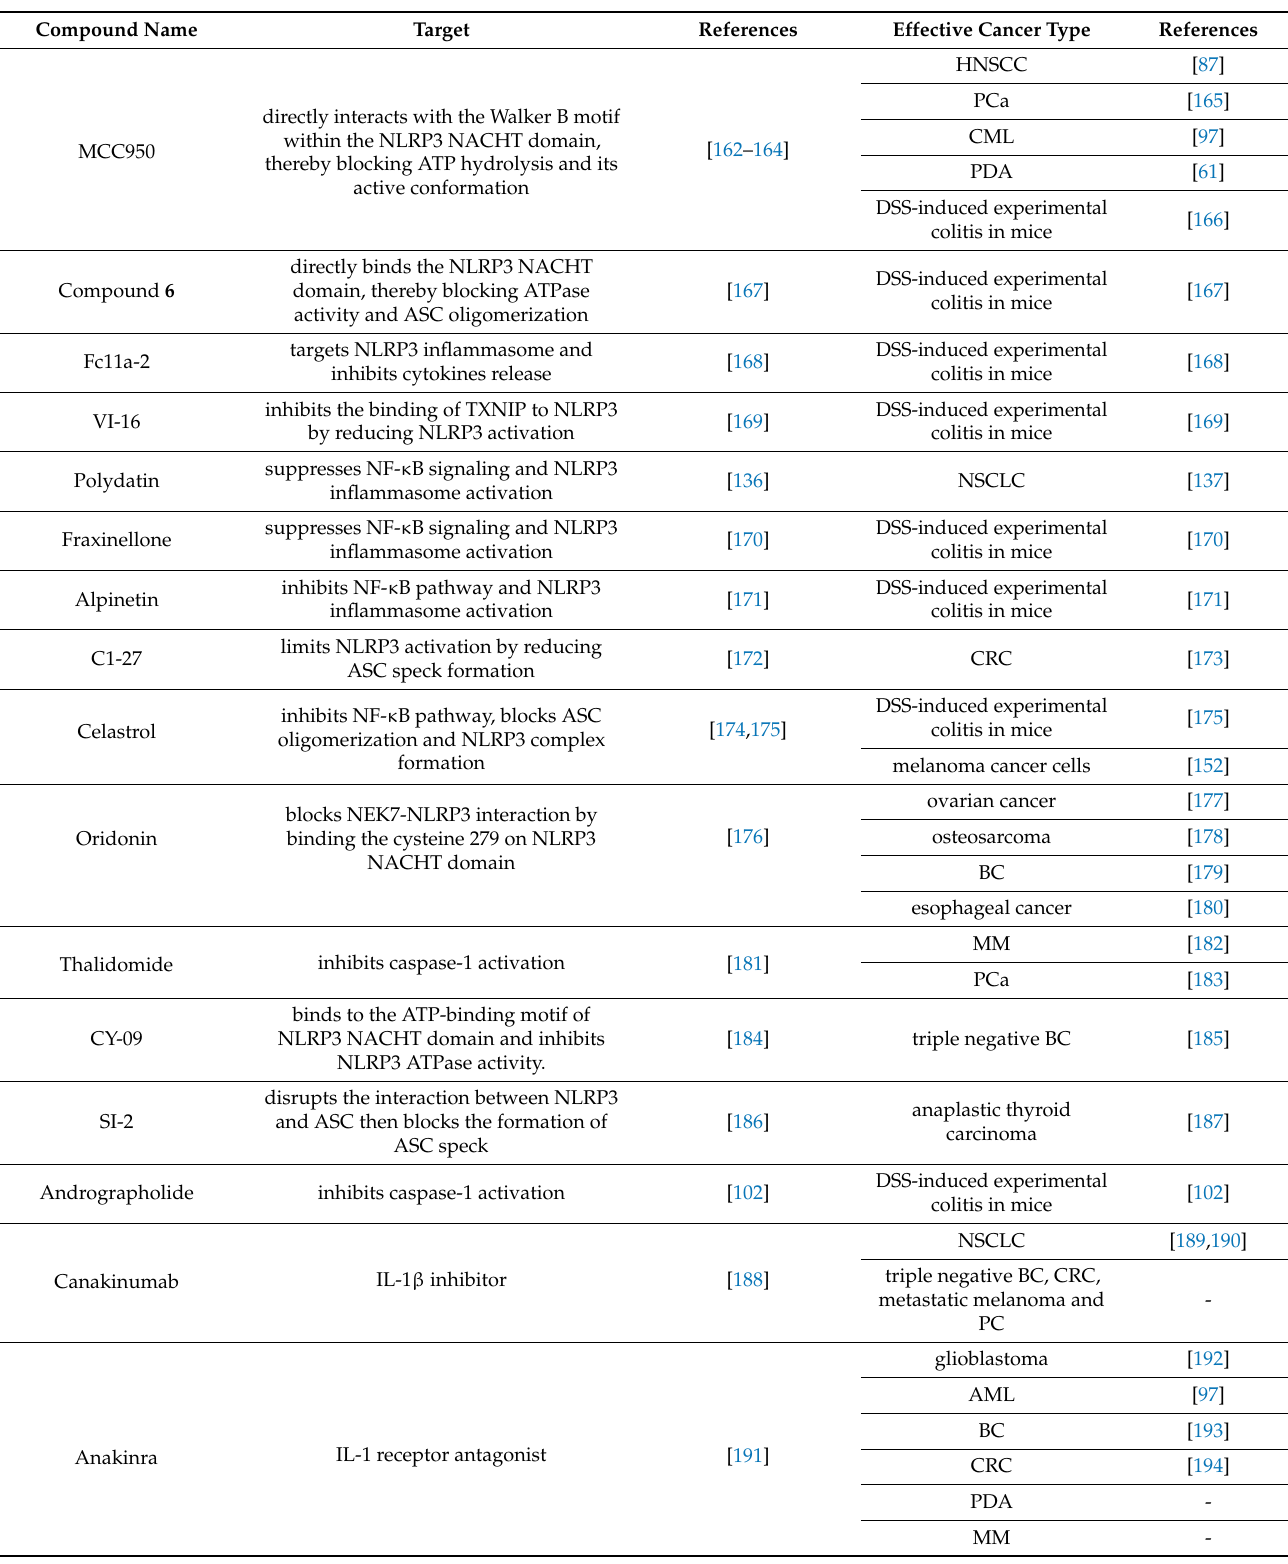
Table 2. List of compounds that impinge on NLRP3 inflammasome activation and have a potential in cancer